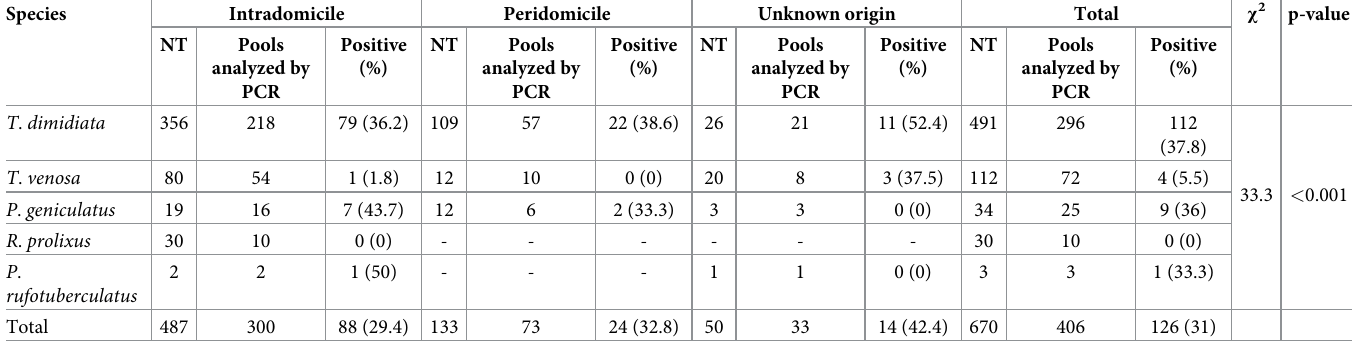
Table 3. T . cruzi infection rates evaluated in the triatomine species collected in intra- or peridomiciles in the 29 infested municipalities (Boyaca department, Colombia), from March 2017 to November 2018. NT (Number of Triatomines)